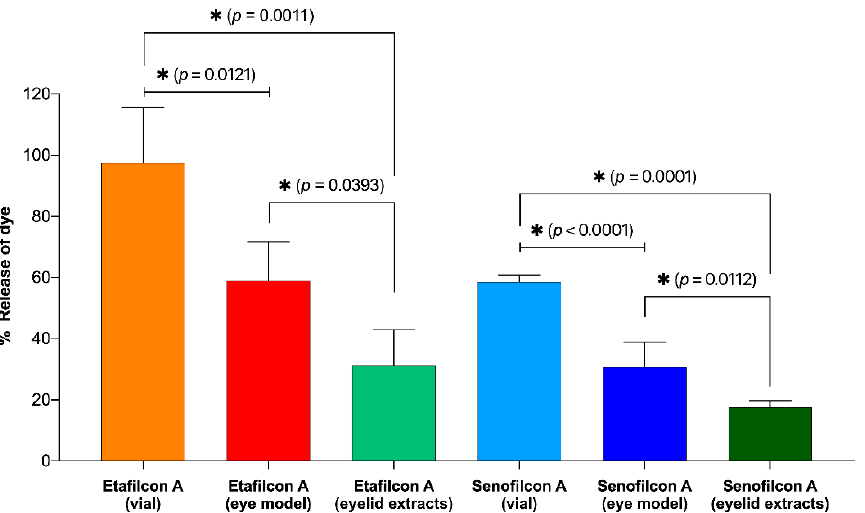
Figure 5. The percentage of dye released from etafilcon A and senofilcon A after 24 h in the vial and the eye model. * Indicates significant differences ( p < 0.05).